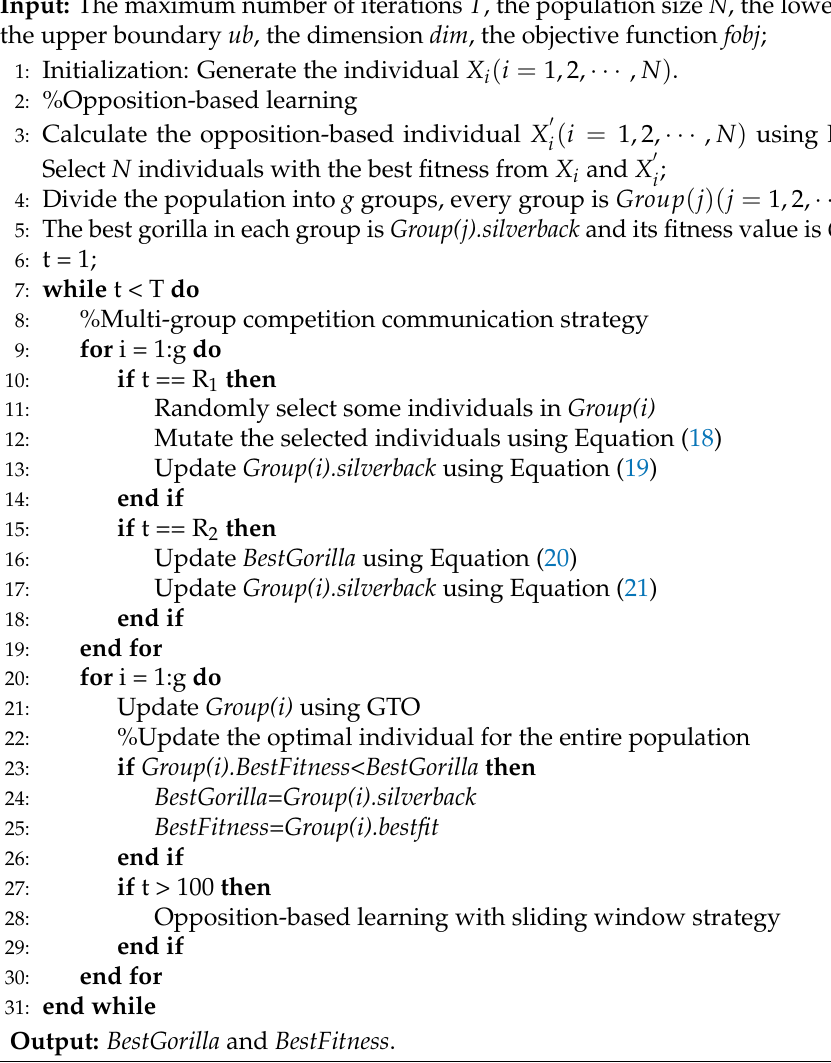
Algorithm 2 OPGTOS2